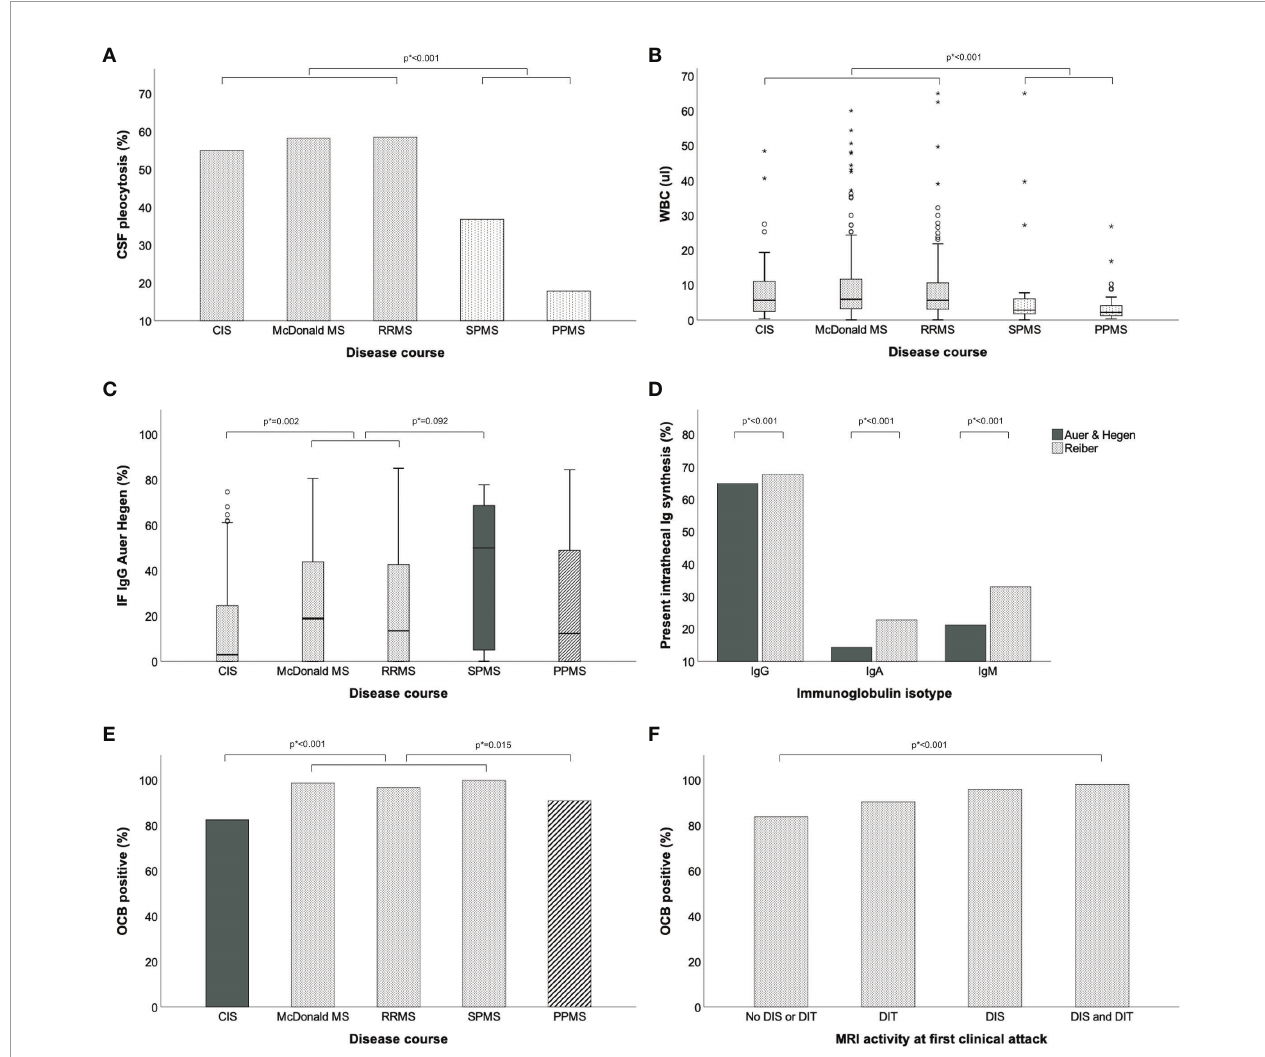
FIGURE 2 | Routine CSF parameters in different MS disease courses. (A) Frequency of elevated WBC count ( ≥ 5/ m l) is higher in relapsing than progressive MS. (B) Median WBC count is higher in relapsing than progressive MS. (C) Intrathecal IgG fraction is higher in secondary progressive than relapsing MS. (D) Frequency of intrathecal IgA and IgM synthesis is lower according to Auer & Hegen than Reiber formula. (E, F) Frequency of CSF-restricted OCB is highest in de fi nite MS. Group comparisons were performed by Mann-Whitney-U test or Pearson Chi-squared test. P values (marked as p*) were corrected for multiple comparisons after Bonferroni. CIS, clinically isolated syndrome; CSF, cerebrospinal fl uid; DIS, dissemination in space; dissemination in time; IF, intrathecal fraction; Ig, immunoglobulin; MRI, magnetic resonance imaging; MS, multiple sclerosis; OCB, oligoclonal bands; PPMS, primary progressive multiple sclerosis; RRMS, relapsing-remitting multiple sclerosis; SPMS, secondary progressive multiple